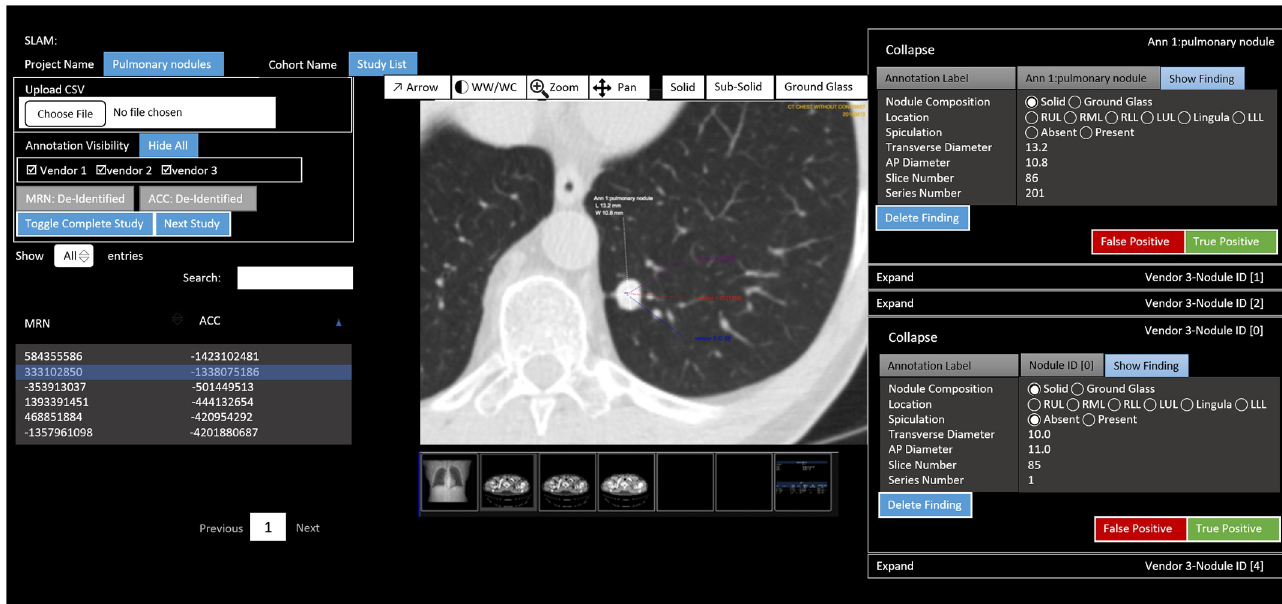
Fig 5. Image annotation-visualization tool showing zoom into features of vendor-detected nodules.